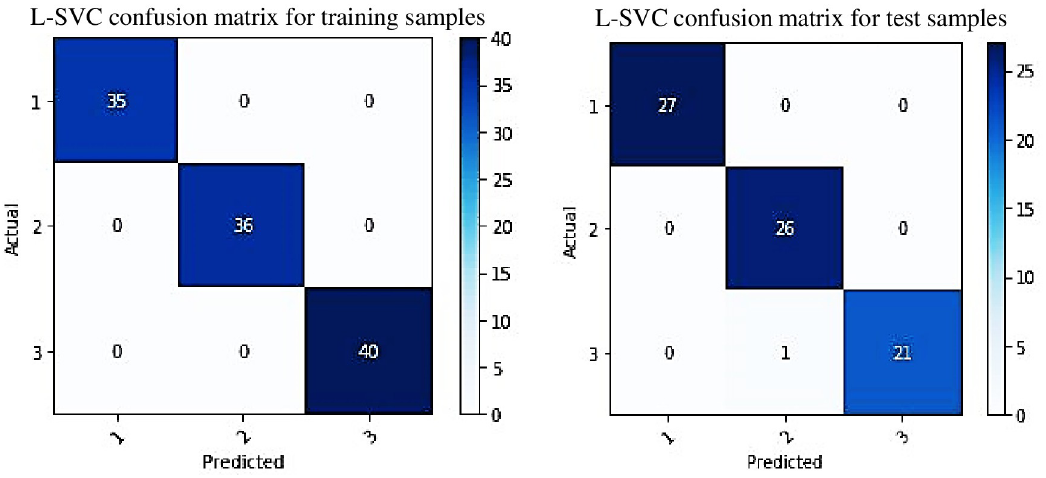
Fig 17. Confusion matrix of the adopted